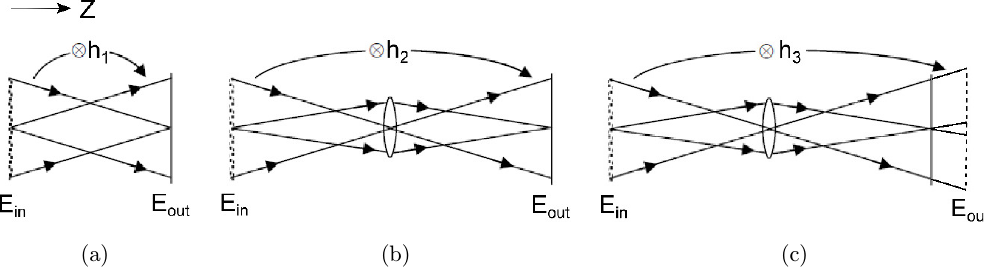
Fig. 4. The relationship of input ¯eld E in and output ¯eld E out under coherent illumination in paraxial approximation. E in ð r Þ and E r Þ are separately corresponding to the complex amplitudes of optical ¯eld in the input plane (P3) and output plane ( P 2 0 ), out ð which are shown in Fig. 3. (a) Free space propagation model: No lens is used; (b) Focal plane model: E out ð r Þ is right at the image plane of E in ; (c) Defocused plane model: E out ð r Þ is at the right side of the image plane of E in .